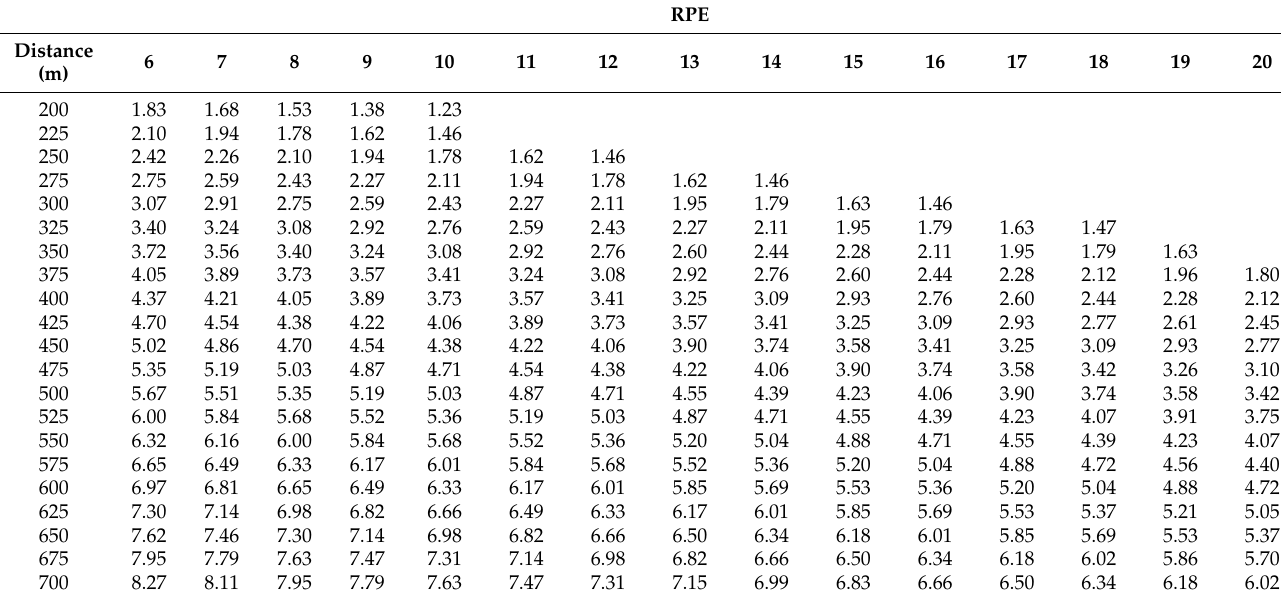
Table 3. Estimate of Metabolic Equivalents at the ventilatory threshold in relation to 6-min walk test (6MWT) distance (m) and terminal rating of perceived exertion (RPE). For convenience of presentation, 6MWT distance is incremented by 50 m. However, as the equation is linear, interpolation of intermediate values is